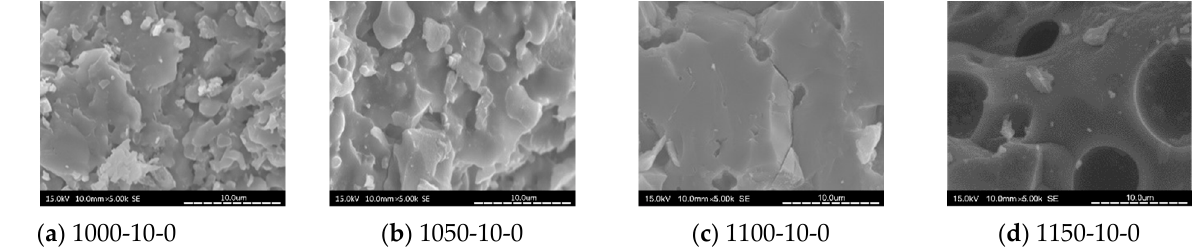
Figure 10. SEM of 10% SSA replacement and no MIBA at different kiln temperatures. ( a ) 1000 °C ‐ 10% SSA ‐ 0% MIBA; ( b ) 1050 °C ‐ 10% SSA ‐ 0% MIBA ; ( c ) 1100 °C ‐ 10% SSA ‐ 0% MIBA ; ( d ) 1150 °C ‐ 10% SSA ‐ 0% MIBA.